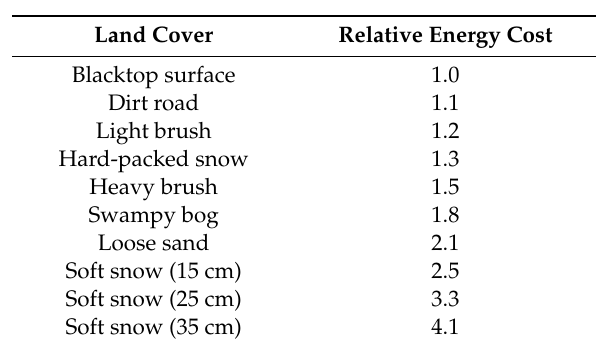
Table 1. Relative energetic cost of pedestrian movement through various land cover types, adapted from [15,16].